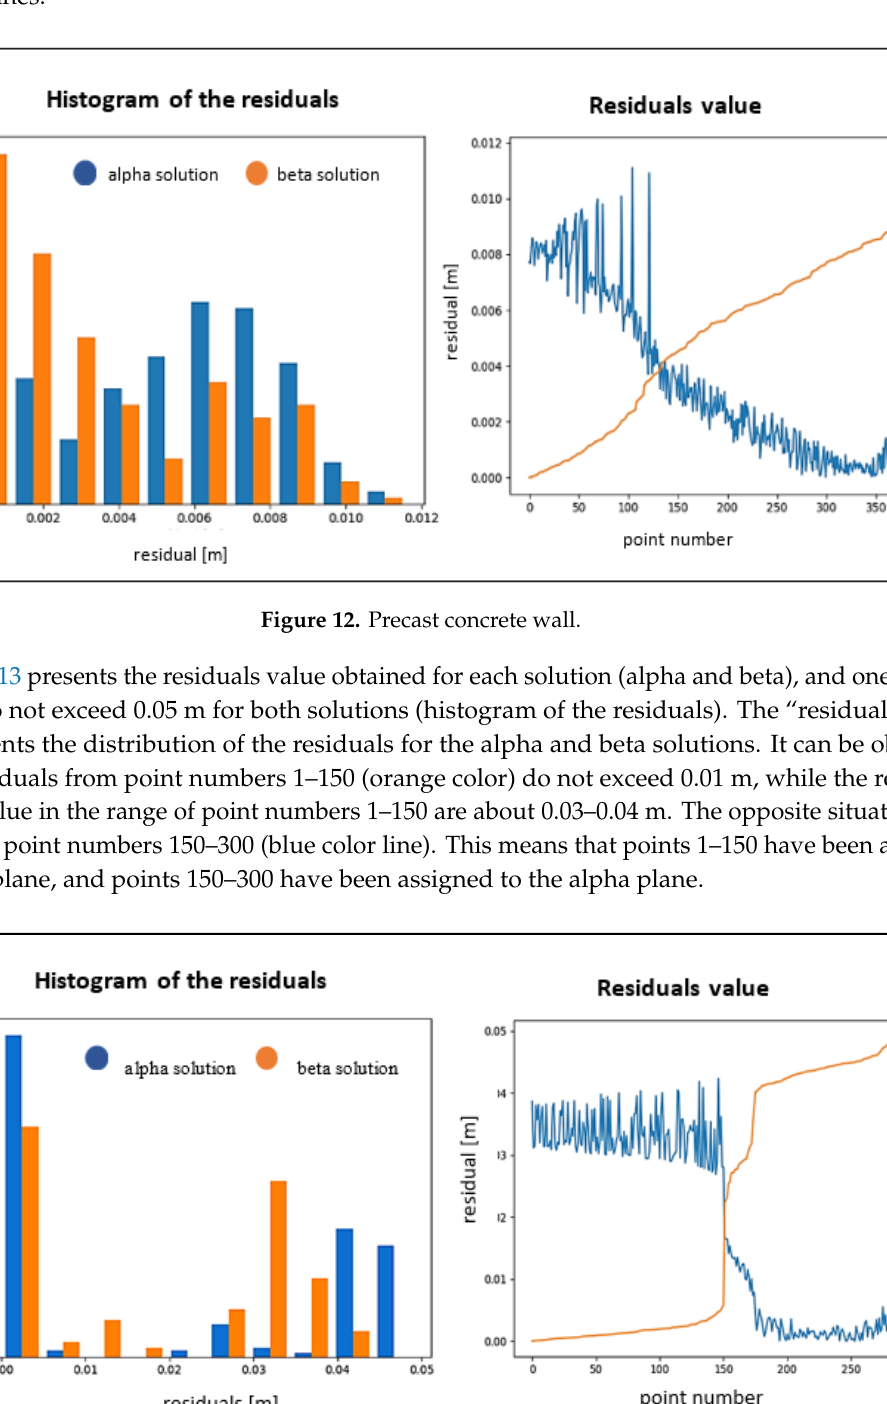
Figure 14. Asphalt road. Figure 15. Concrete pavement.